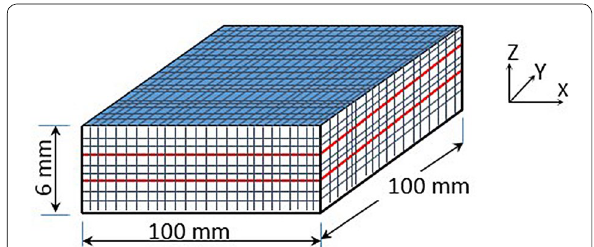
Fig. 1 Geometry and mesh of the plywood sample